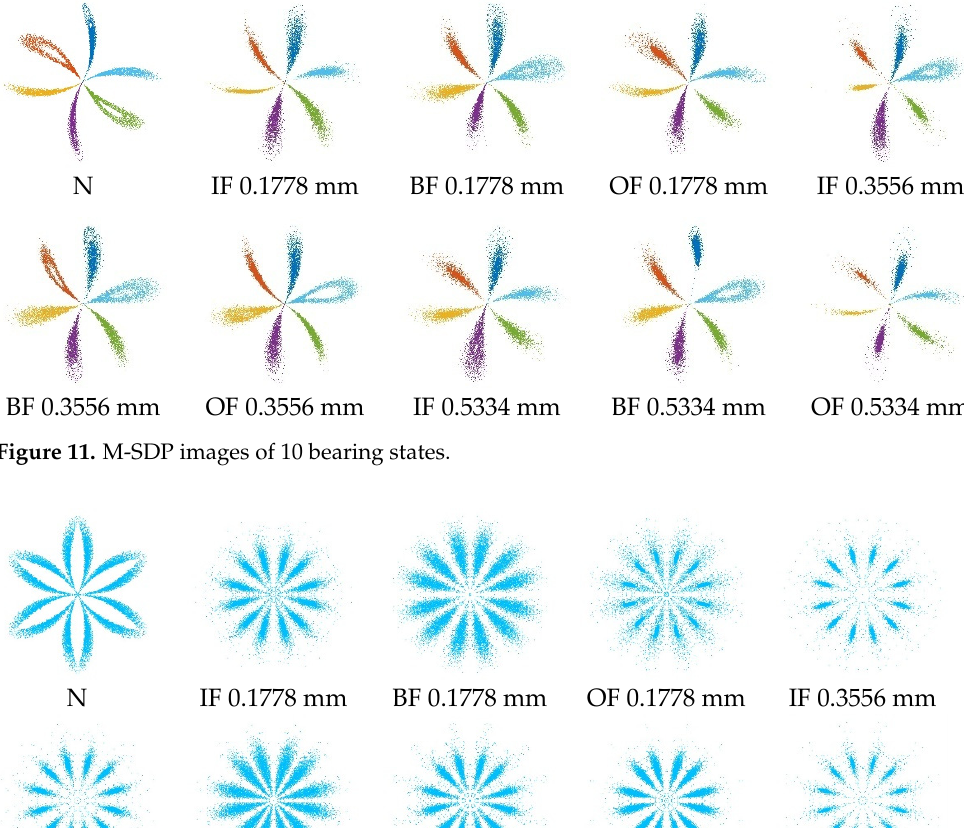
Figure 10. Relationship between NR and internal parameters.